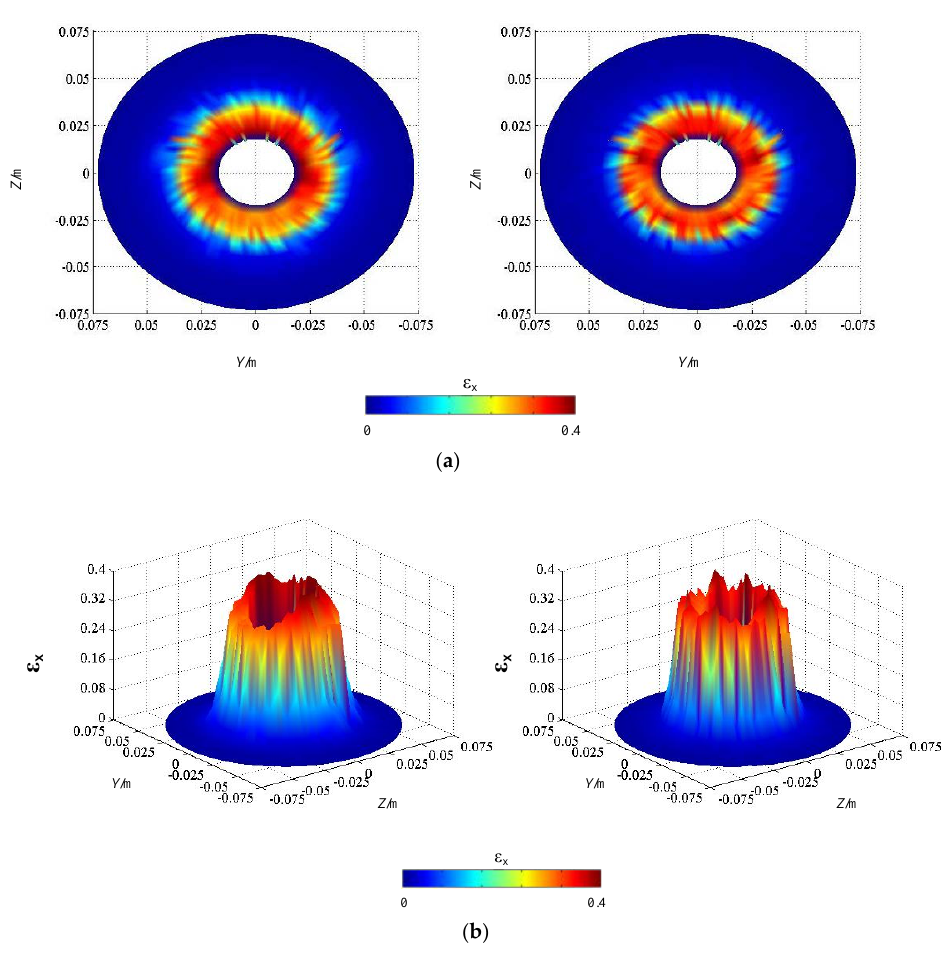
Figure 13. Comparison of turbulence intensity inside the cavity. ( a ) Two-dimensional turbulence intensity inside the cavity at 0 °C (left) and 25 °C (right). ( b ) Three-dimensional turbulence intensity inside the cavity at 0 °C (left) and 25 °C (right).